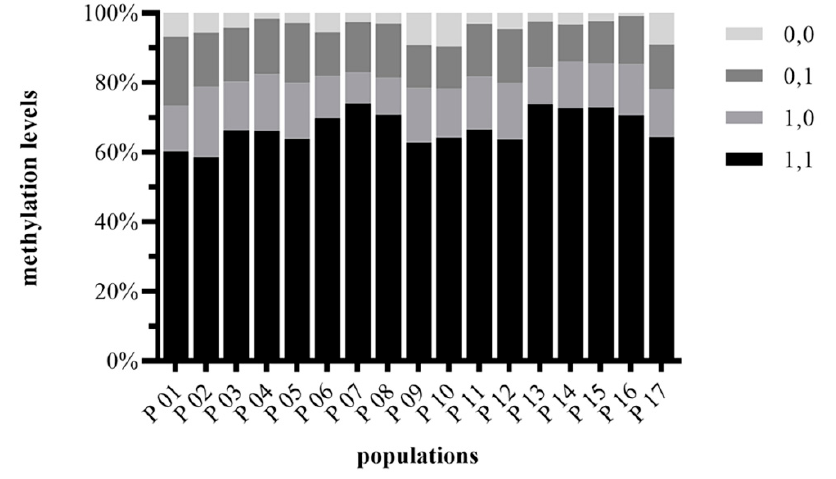
Figure 2. Relative DNA methylation levels in all populations of D. angustifolia. I—fragments present in both profiles (1,1), unmethylated state; II—fragments were present only with EcoRI/HpaII (1,0), hemi-methylation of external cytosine; III—fragments were present only with EcoRI/MspI (0,1), full-methylation of internal cytosine; IV—fragments were absent with both profile (0,0), uninformative site.